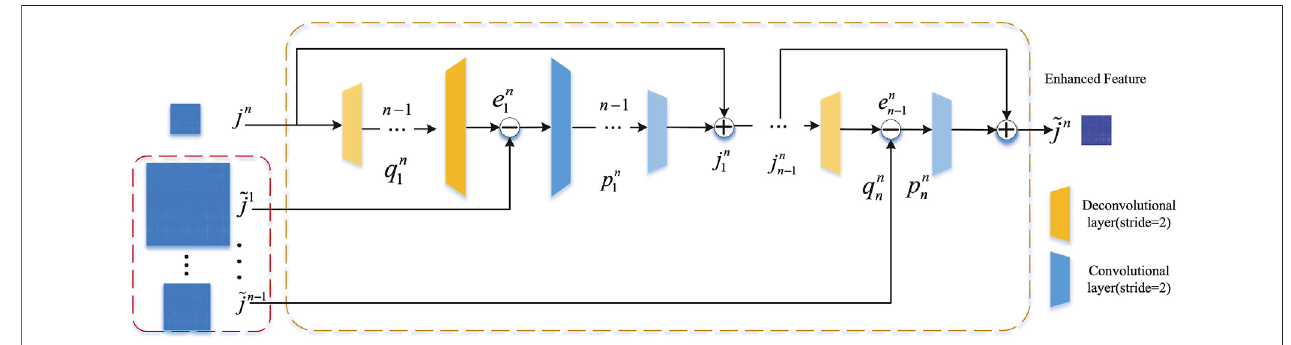
FIGURE 3 | The MSFF